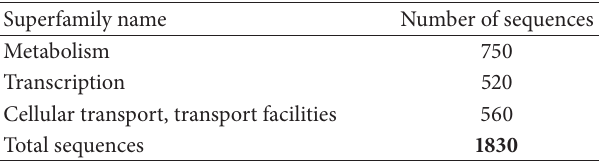
Table 4: Details of dataset 1 used in the experiments.